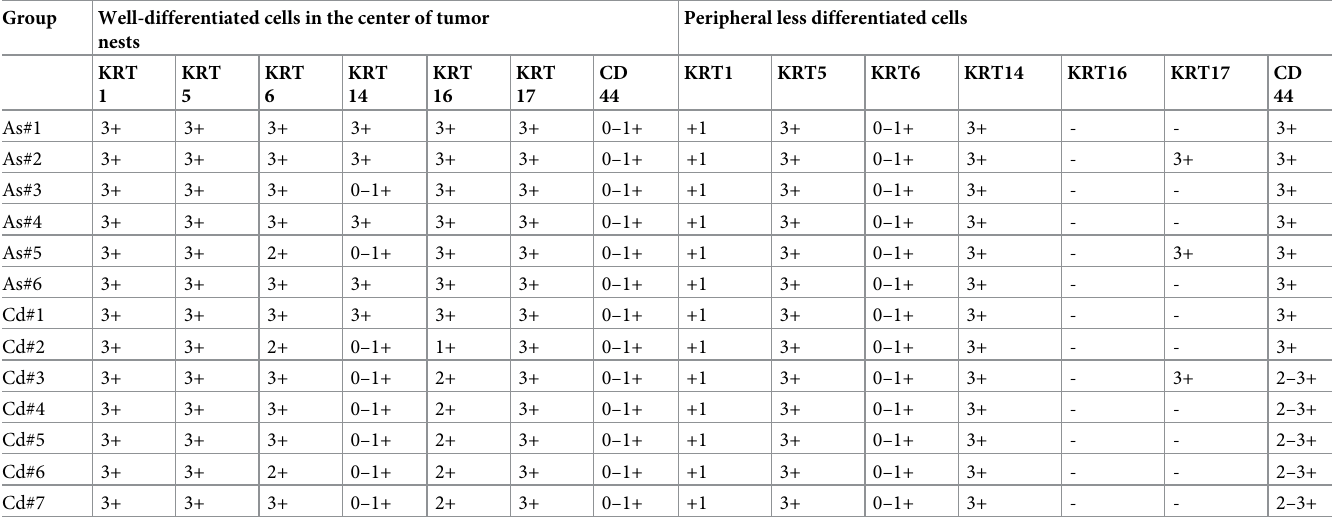
Table 2. Localization of basal protein markers in different histological areas of the As 3+ and Cd 2+ tumor transplants. Group Well-differentiated cells in the center of tumor nests